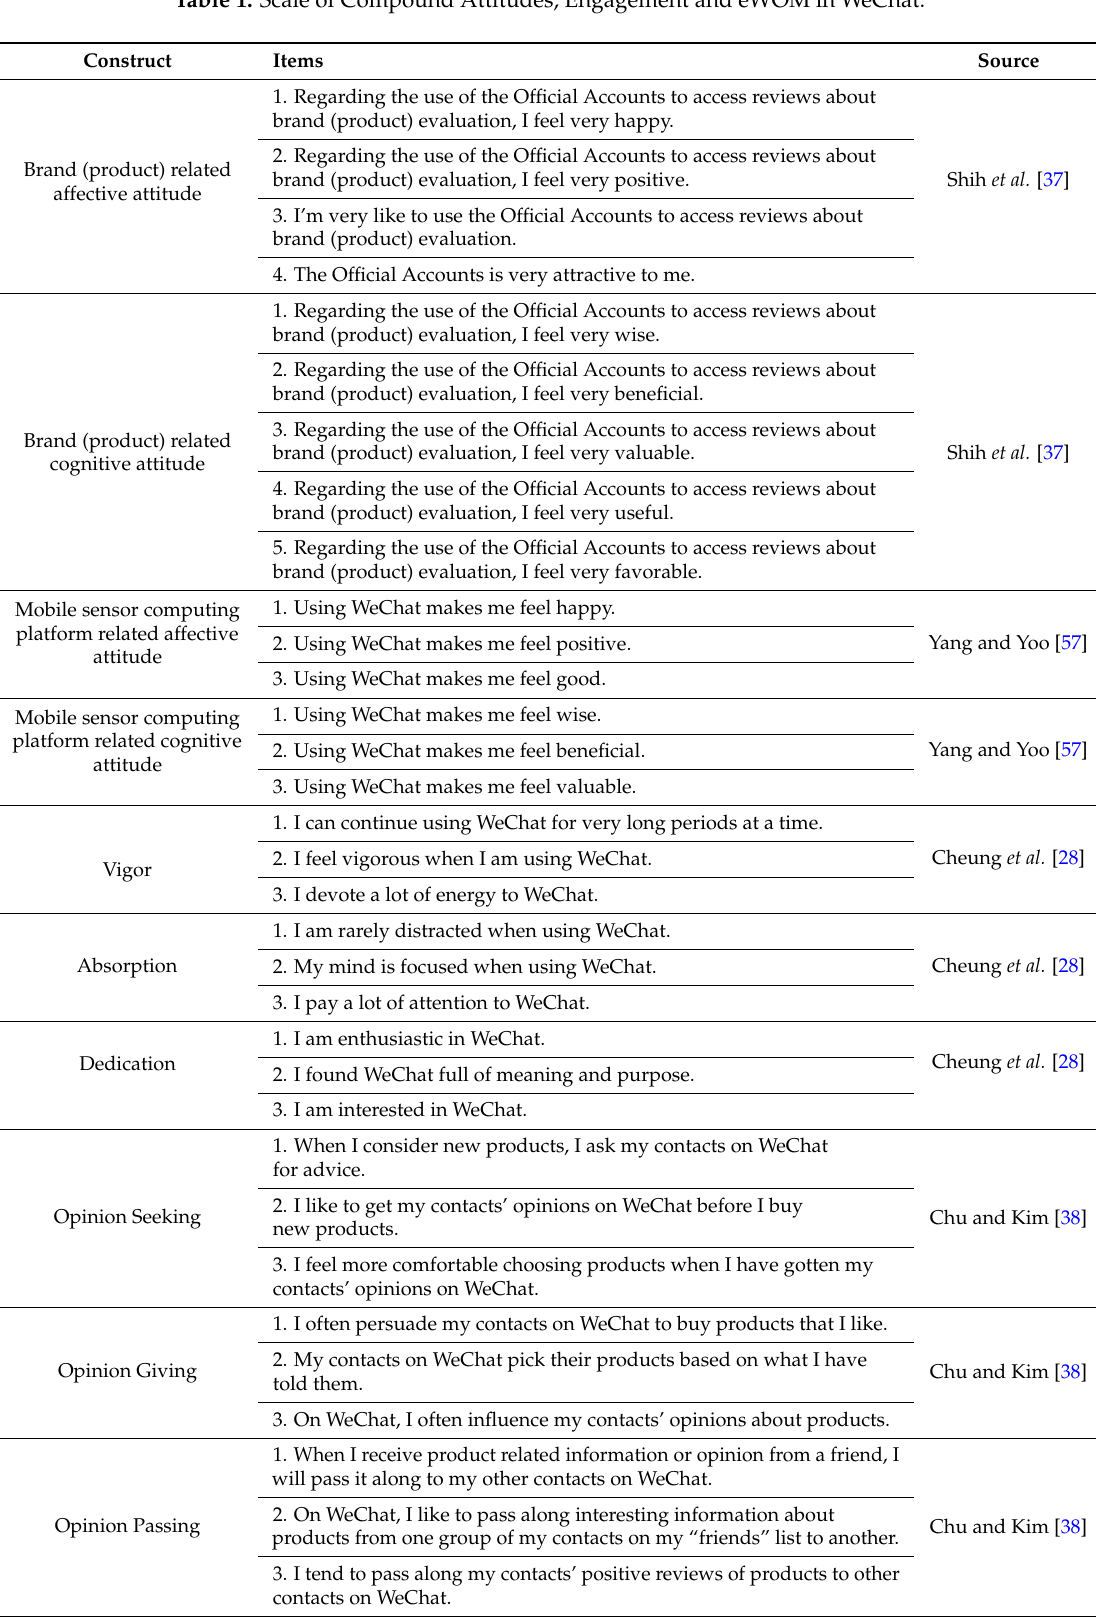
Table 1. Scale of Compound Attitudes, Engagement and eWOM in WeChat. Construct